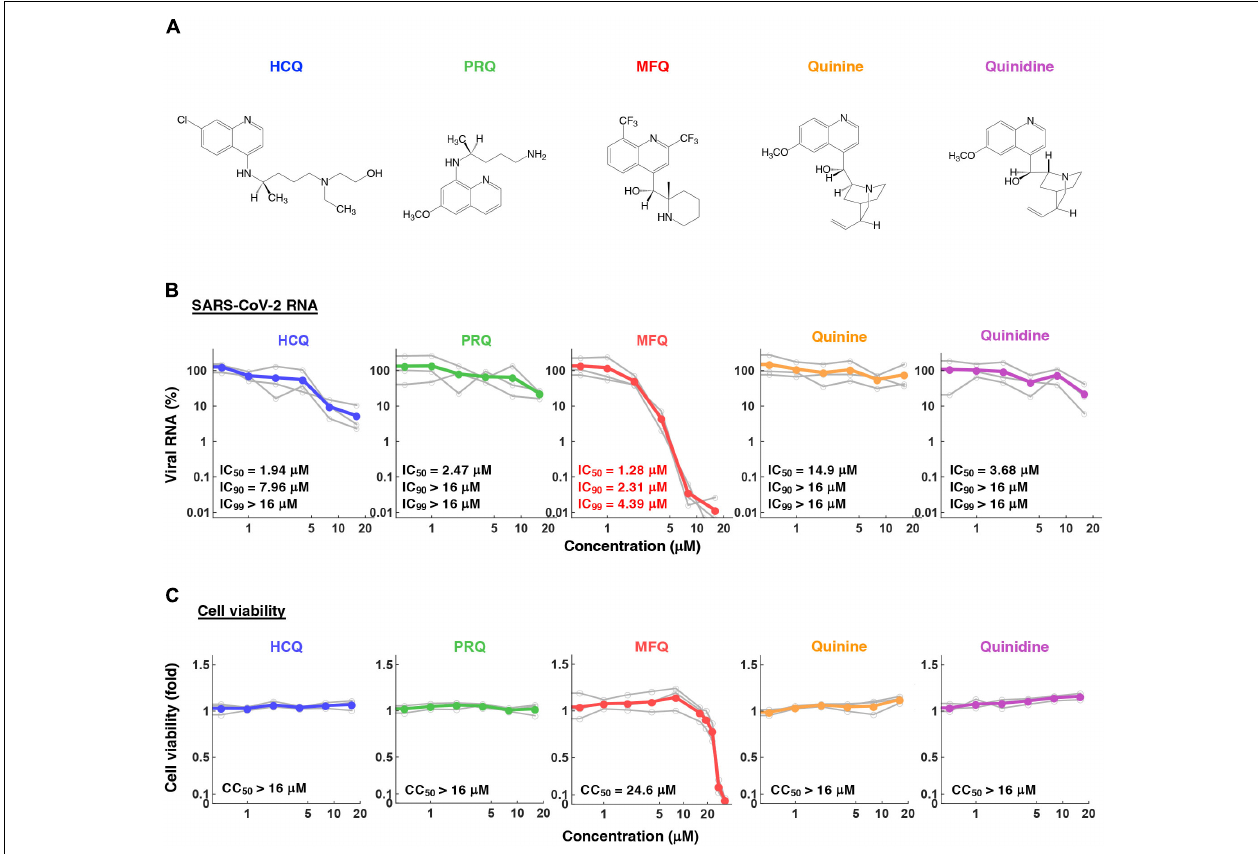
FIGURE 2 | The anti-SARS-CoV-2 activity of MFQ and its derivatives. (A) Chemical structures of MFQ and its derivatives. (B) Extracellular SARS-CoV-2 RNA was quantified upon treatment with HCQ, MFQ and related compounds PRQ, Quinine and Quinidine at varying concentrations. Calculated inhibitory concentrations of 50, 90, and 99% maximum (IC 50 , IC 90 , and IC 99 ) for each compound are as indicated. (C) Cell viability was measured by MTT assay with the calculated 50% maximal cytotoxic concentration (CC 50